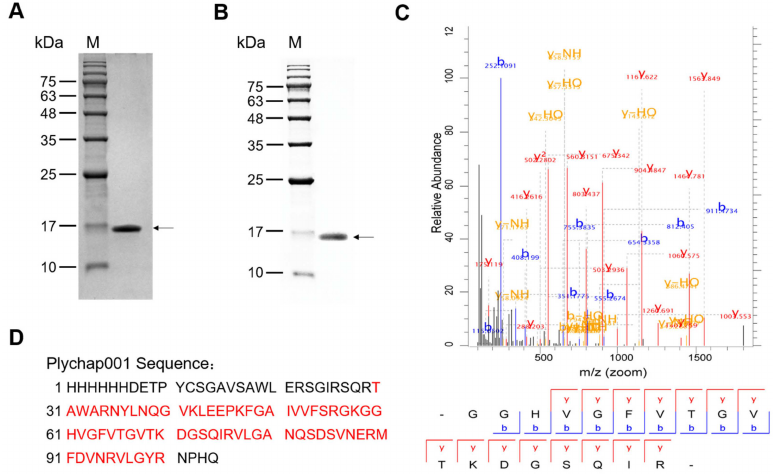
Figure 2. Expression and identification of Plychap001. ( A ) SDS-PAGE gel (12%) analysis of recombi- nant Plychap001 after purification and renaturation. ( B ) Detection of recombinant Plychap001 using western blotting. ( C ) Fragment ion spectrum of the GGHVGFVTGVTKDGSQIR peptide, i.e., one of the peptides matched with Plychap001. ( D ) Peptide fragments corresponding to Plychap001 amino acid sequence (indicated in red) identified in mass spectrometry. M: marker, indicated in the left margin in